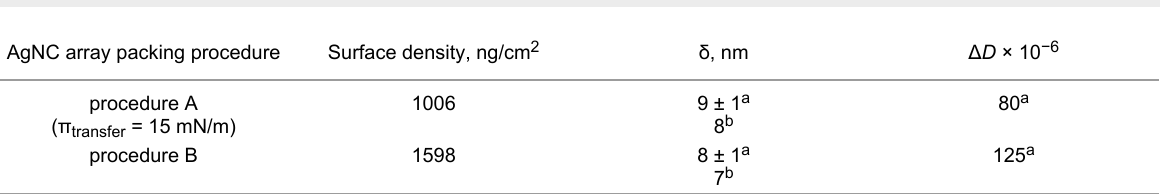
Table 2: Main physico-chemical parameters for GO layer on AgNC arrays.